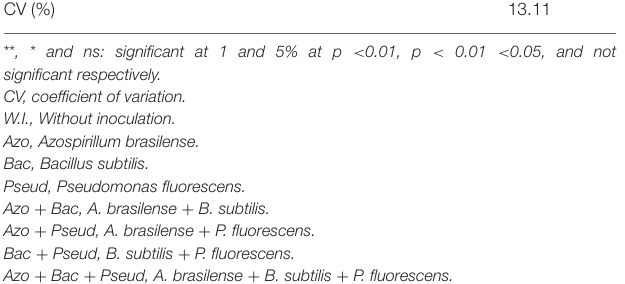
Stalks yield (kg ha − 1